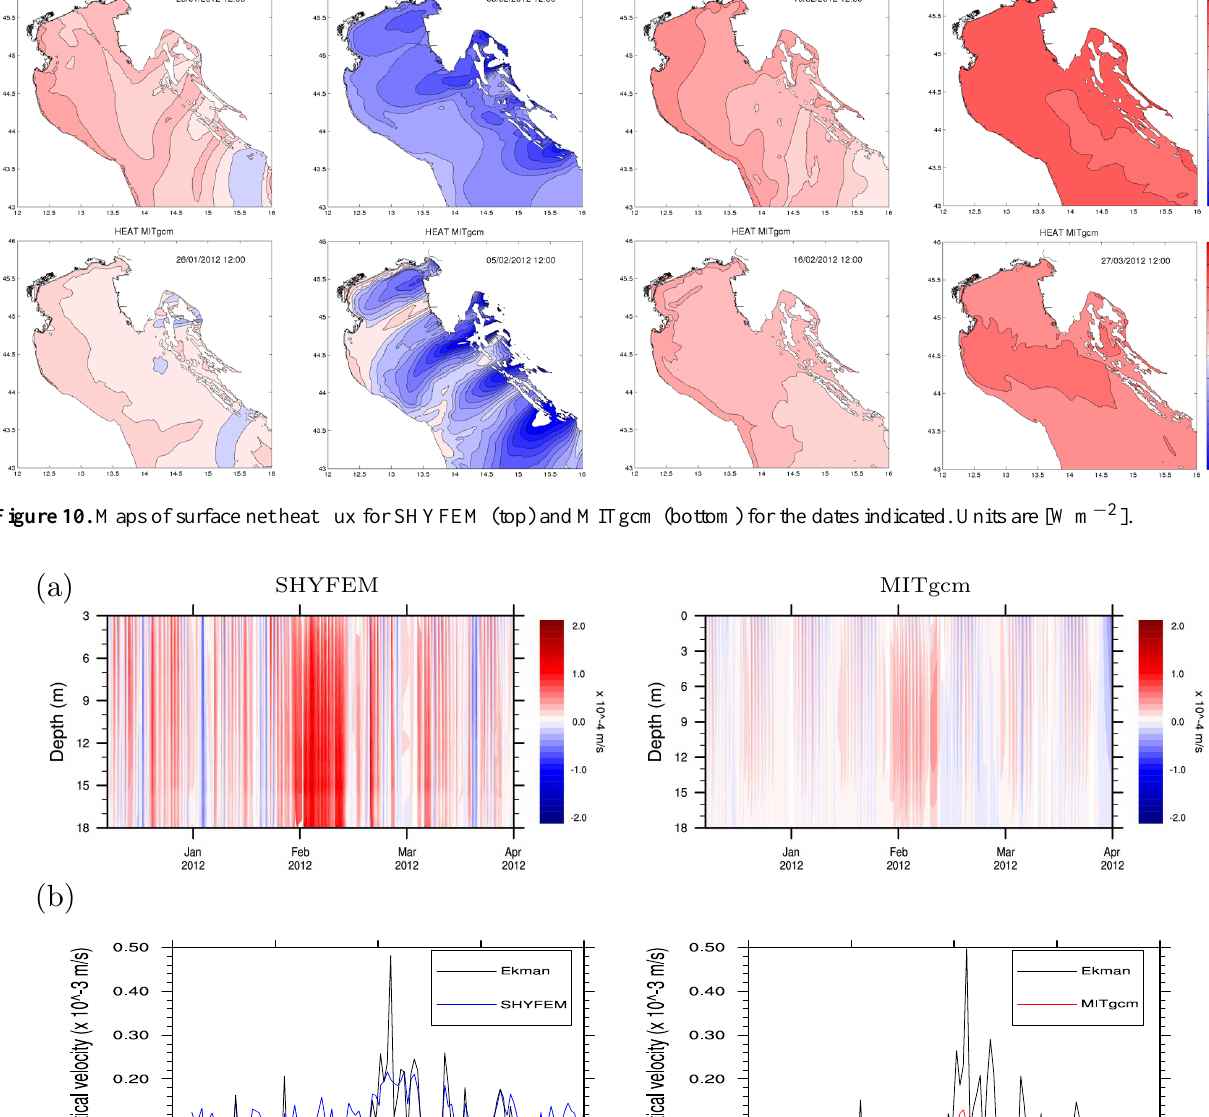
velocity is detected by both models during the DW